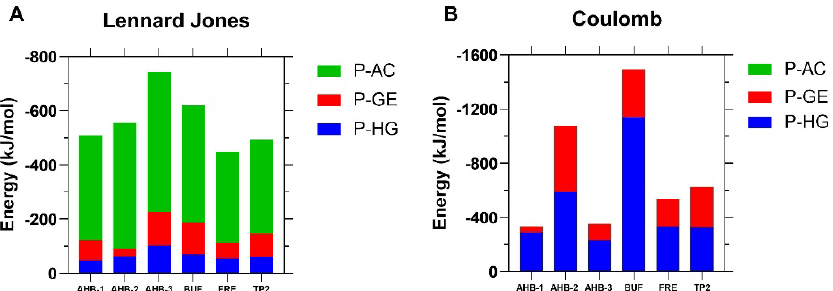
Figure 6. Interaction energies between the peptides and the membrane’s groups. ( A ) Non-bonded energies described by the Lennard Jones Potential and separated into the contribution for each mem- brane’s components. ( B ) Electrostatic interaction energies. P-AC: Peptide-Acyl Chains interactions, P-GE: Peptide-Glycerol Ester interactions, and P-HG: Peptide-Headgroups interactions.